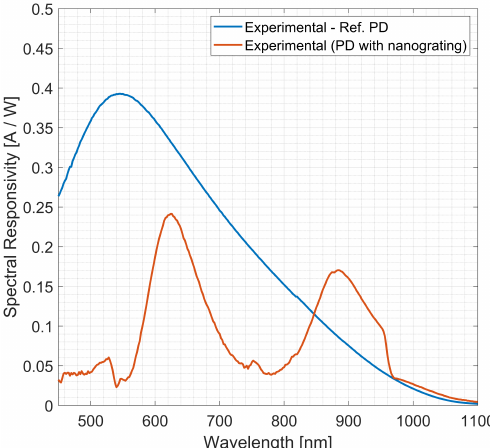
Figure 9. Measured spectral responsivity of a reference PD (blue solid line), measured SR of the integrated PD (orange solid line) as a function of the incident wavelength in the range (450 - 1100) nm.